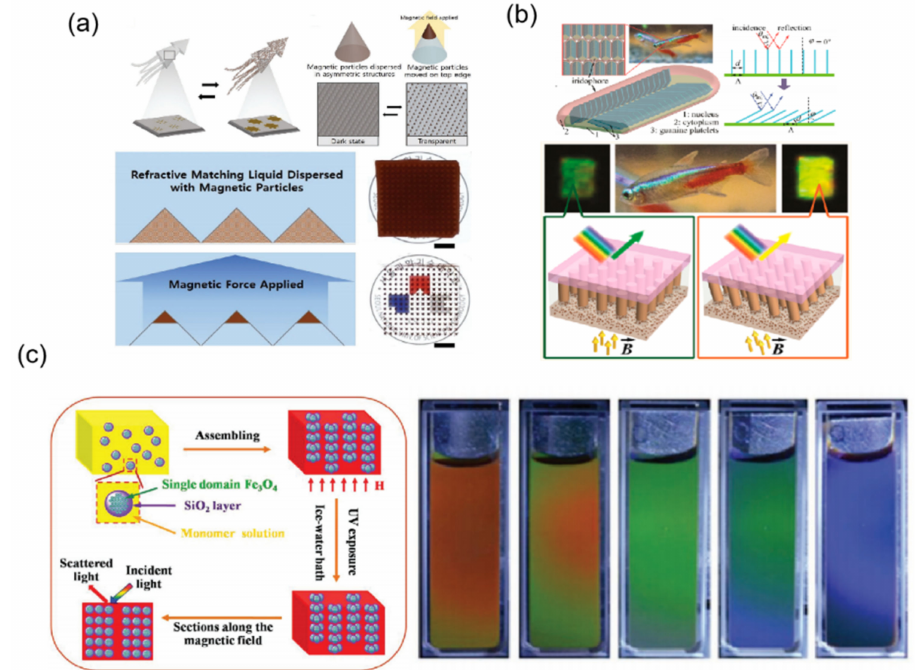
Figure 11. The strategy of magnetic driving mode mechanoresponsive smart windows: ( a ) adjusting the ratio of magnetic nanoparticles to change transmittance [70] Copyright 2019, John Wiley and Sons, ( b ) forming the magnetic nanopillars array to adjust transmittance [71] Copyright 2019, American Chemical Society, ( c ) forming magnetothermal hydrogel to modulate transmittance [72] Copyright 2018, John Wiley and